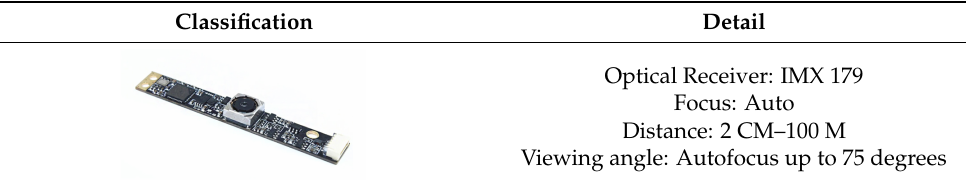
Table 2. Camera image and specifications.